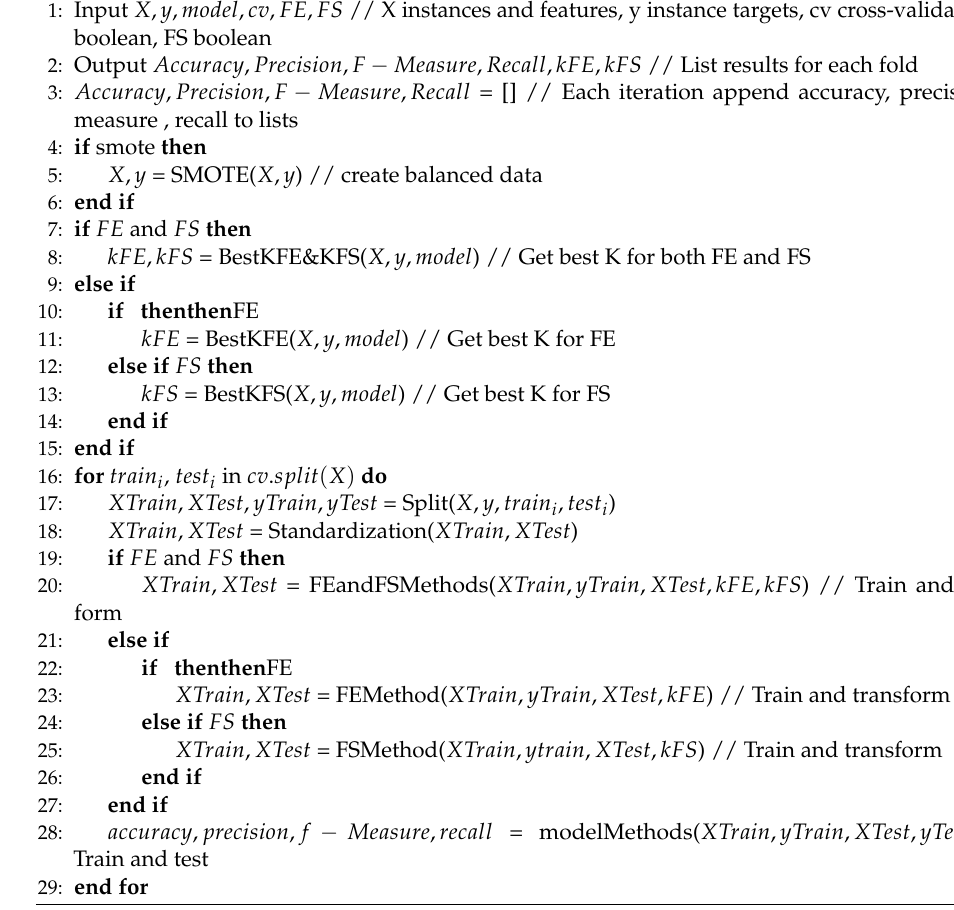
Algorithm 1 Experiment